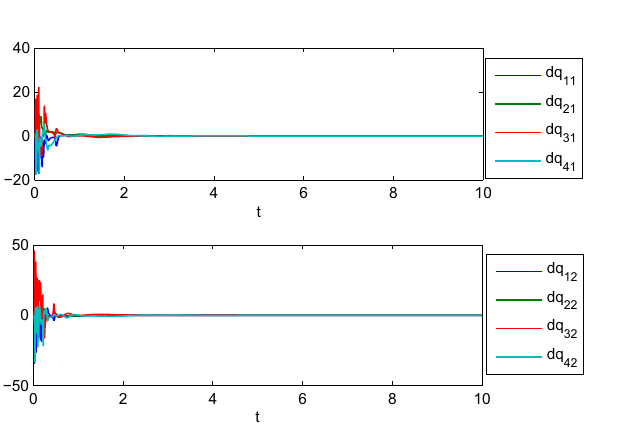
Figure 3. Complete consensus progress for the generalized positions of four two-link manipulators.